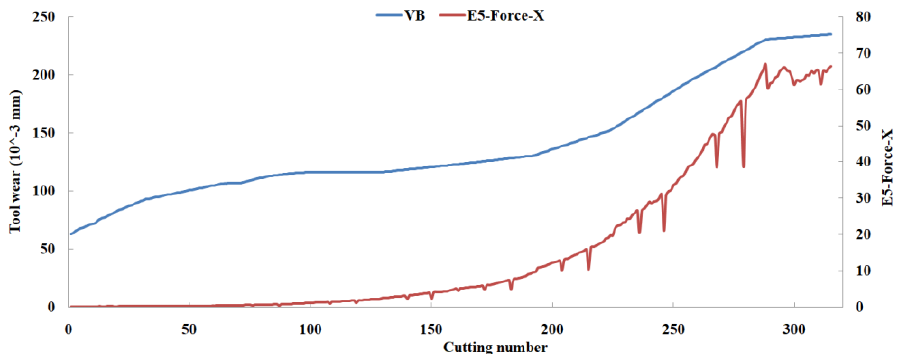
Figure 15. The scatter diagram between E 5 in X-dimension Force and tool wear value.